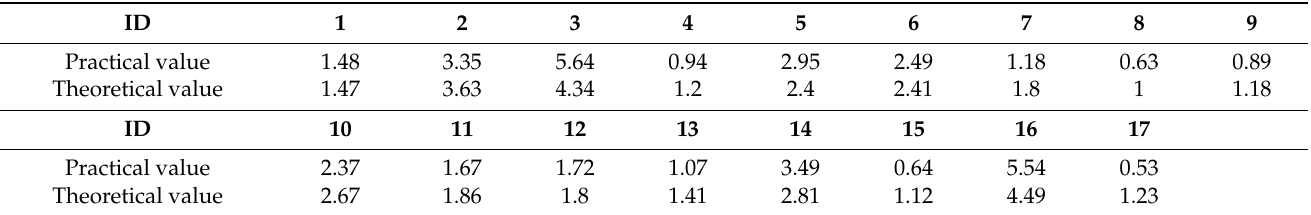
Table 2. Verification of model